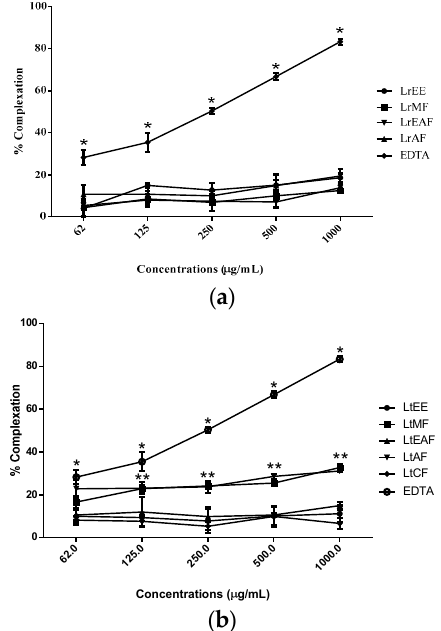
Figure 2. Iron chelating activity of Licania rigida ( a ) and L. tomentosa ( b ) seeds ethanolic extract and their fractions based on o -phenantroline method. Absorbance was recorded at 510 nm and percent complexation was calculated with respect to control (determined in the absence of samples and EDTA). LrEE = L. rigida ethanolic extract; LrMF = L. rigida methanolic fraction; LrEAF = L. rigida ethyl acetate fraction; LrAF = L. rigida aqueous fraction LtEE = L. tomentosa ethanolic extract; LtMF = L. tomentosa methanolic fraction; LtEAF = L. tomentosa ethyl acetate fraction; LtAF = L. tomentosa aqueous fraction; LtCF = L. tomentosa chloroform fraction; EDTA = Ethylenediamine tetraacetic acid. * Significant difference between EDTA control and all the samples in A and B ( p < 0.05). ** Significant difference between LtMF/LtAF and other samples in B ( p < 0.05).